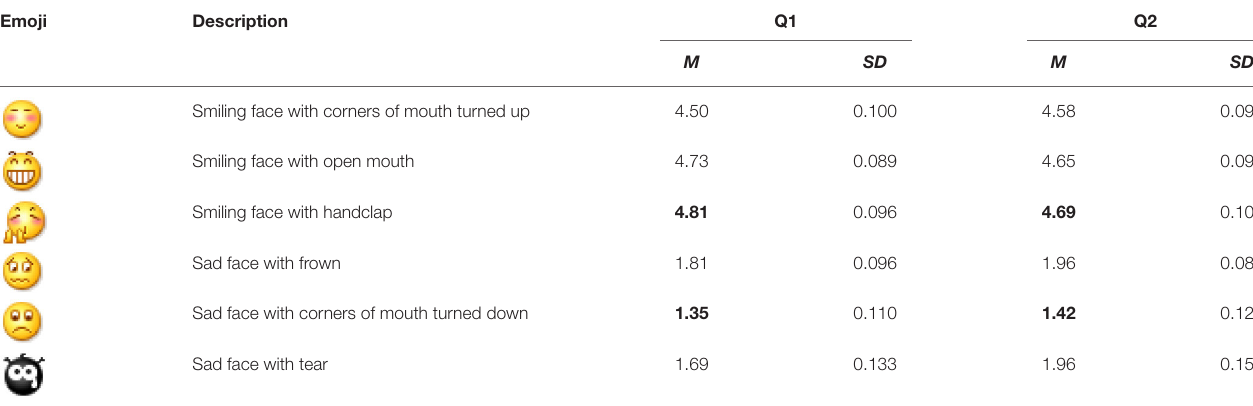
TABLE 1 | Emotion scores of the different emojis used in this study.